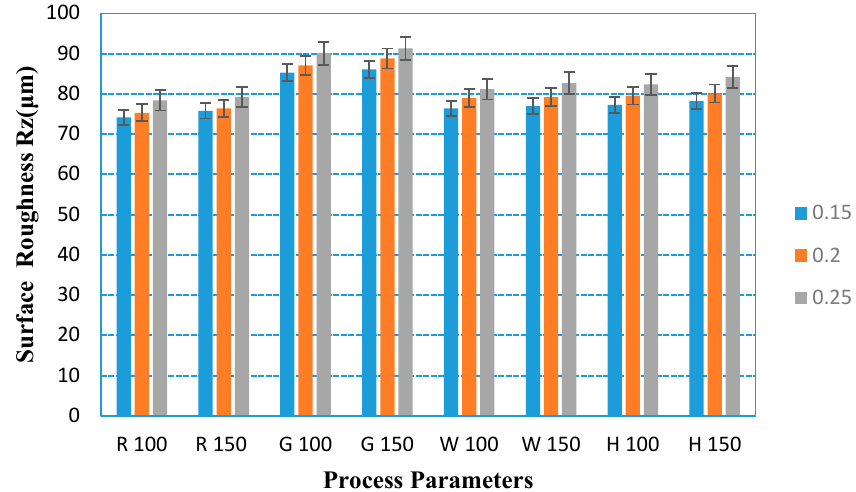
Figure 9. Surface roughness of PLA tested parts under different process parameters .